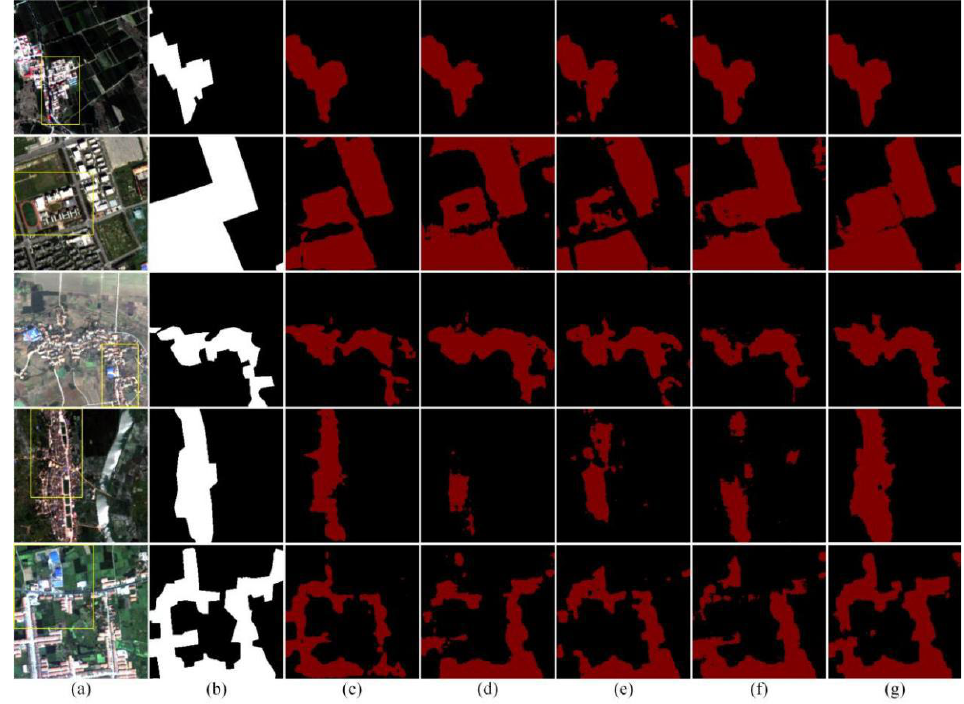
Figure 8. Typical building extraction results on the GID. ( a ) Images. ( b ) Labels. ( c ) DeepLabv2. ( d ) PSPNet. ( e ) UNet. ( f ) TransUNet. ( g ) TRANet. Yellow boxes identify partial differences between the different methods.